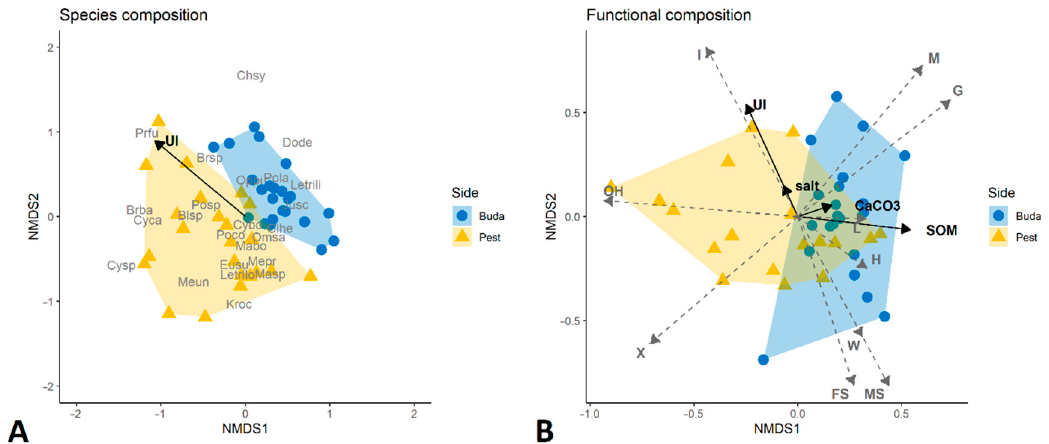
Figure 4. Non-metric multidimensional scaling (NMDS) analyses of taxonomic ( A ) and functional ( B ) composition of Diplopoda assemblages. For abbreviations of species names, see Table 2. The significant environmental variables are indicated by black arrows: UI, urbanization index; SOM, soil organic matter. The grey dashed arrows indicate the functional traits/ecological preferences: L, length; W, width; FS, forest specialist; G, generalist; H, hygrophilous; I, insensitive; M, mesophilic; MS, moderately sensitive; OH, open habitat; X, xerotolerant.